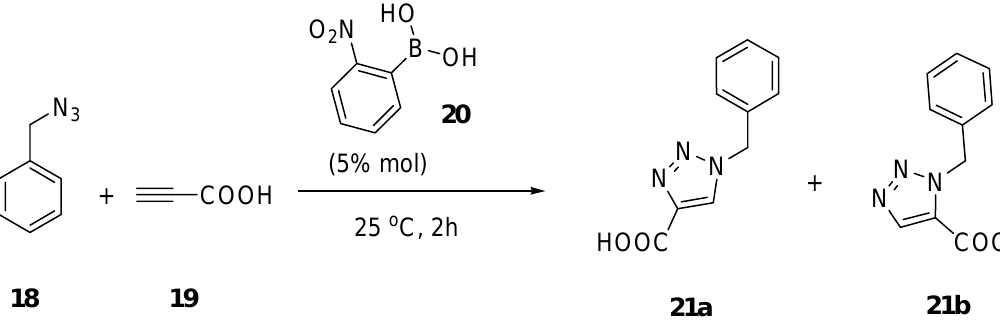
Scheme 7. Ortho-nitrophenylboronic acid catalyzed click